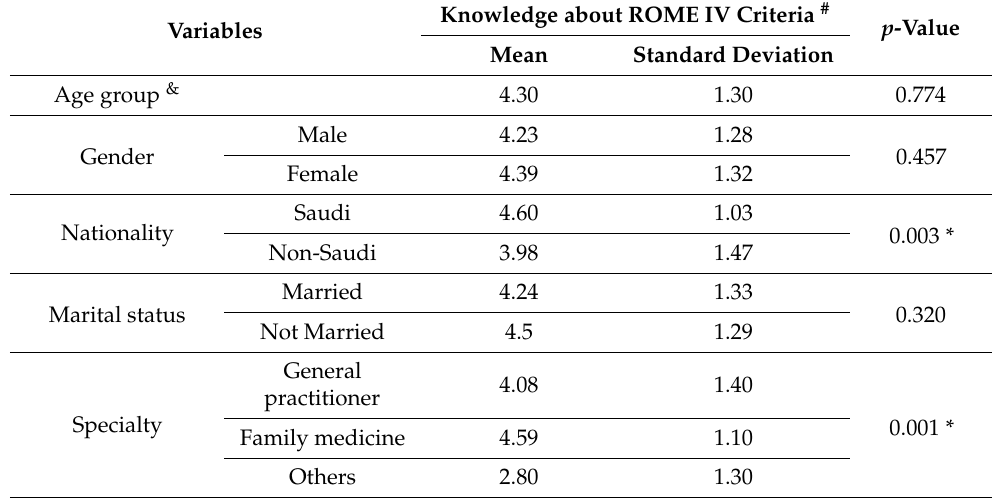
Table 3. The association between ROME IV criteria knowledge (depicted as the mean and standard deviation for the calculated score) and socio-demographic